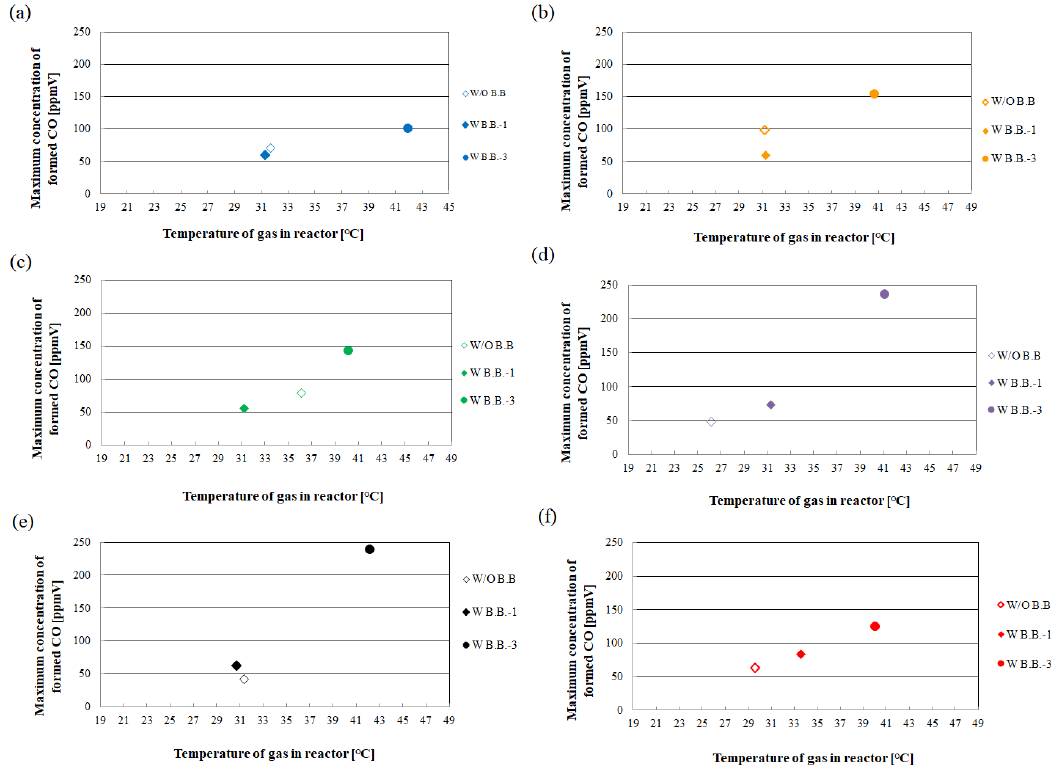
Figure 3. Relationship between temperature of gas in reactor and maximum concentration of formed CO with W/O B.B., W B.B.-1, and W B.B.-3 (( a ): CO 2 :NH 3 = 1:0.5, ( b ): CO 2 :NH 3 = 1:1, ( c ): CO 2 :NH 3 = 1:2, ( d ): CO 2 :NH 3 = 1:4, ( e ): CO 2 :NH 3 = 3:2, ( f ): CO 2 :NH 3 = 3:8).